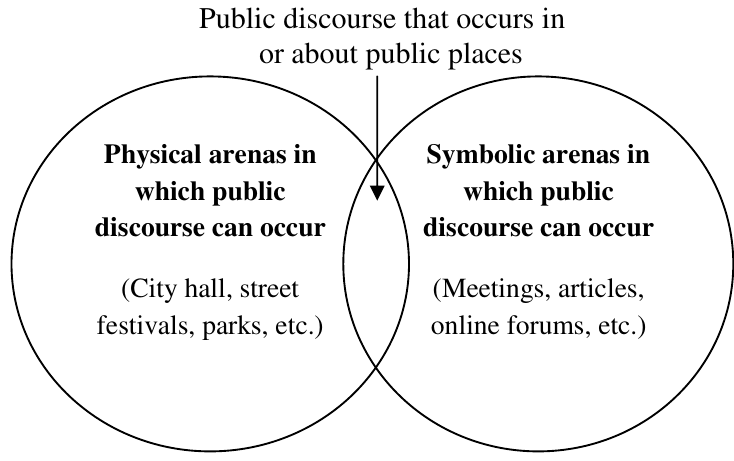
Figure 4: Diagram illustrating locale- and forum-based